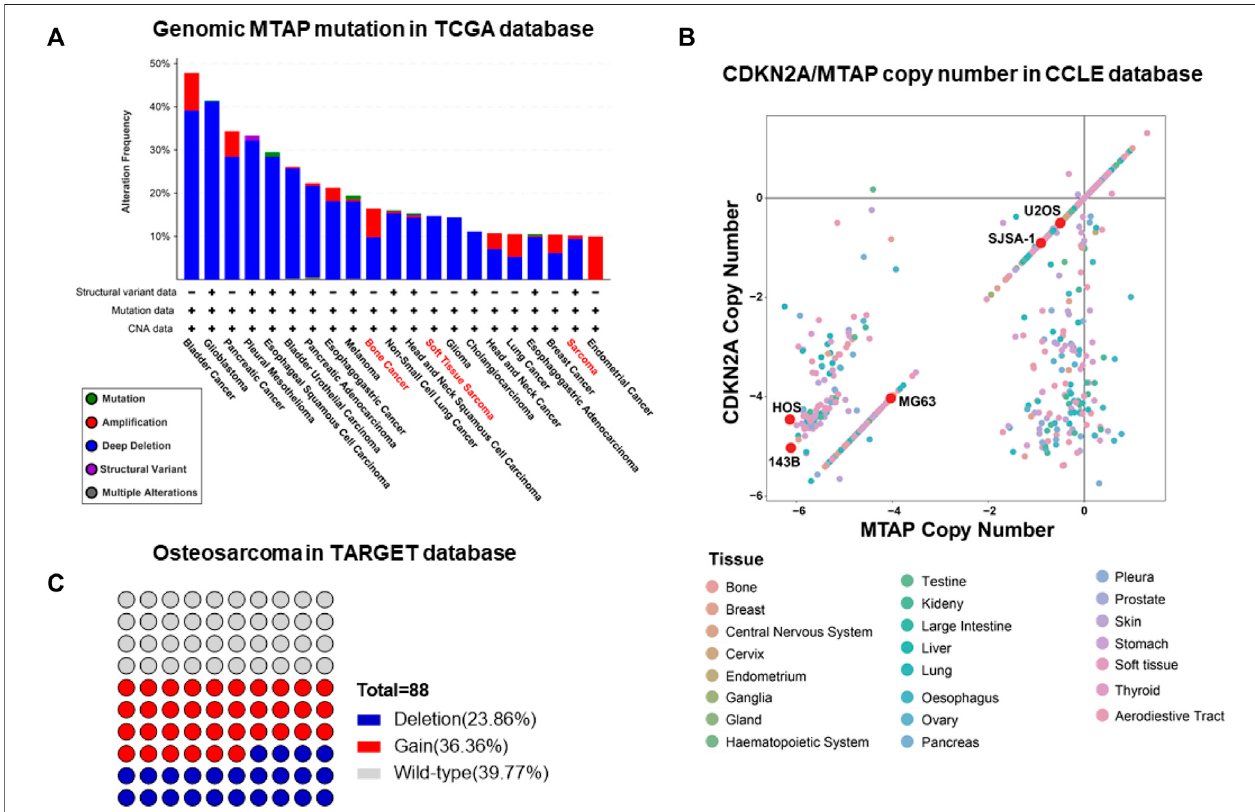
FIGURE1| FrequentoccurrenceoftheMTAPdeletioninosteosarcoma. (A) GenomicmutationofMTAPinpan-cancerintheTCGAdatabase. (B) Copynumberof CDKN2A and MTAP in pan-cancer cell lines in the CCLE database. (C) Genomic mutation of MTAP in osteosarcoma in the TARGET database.